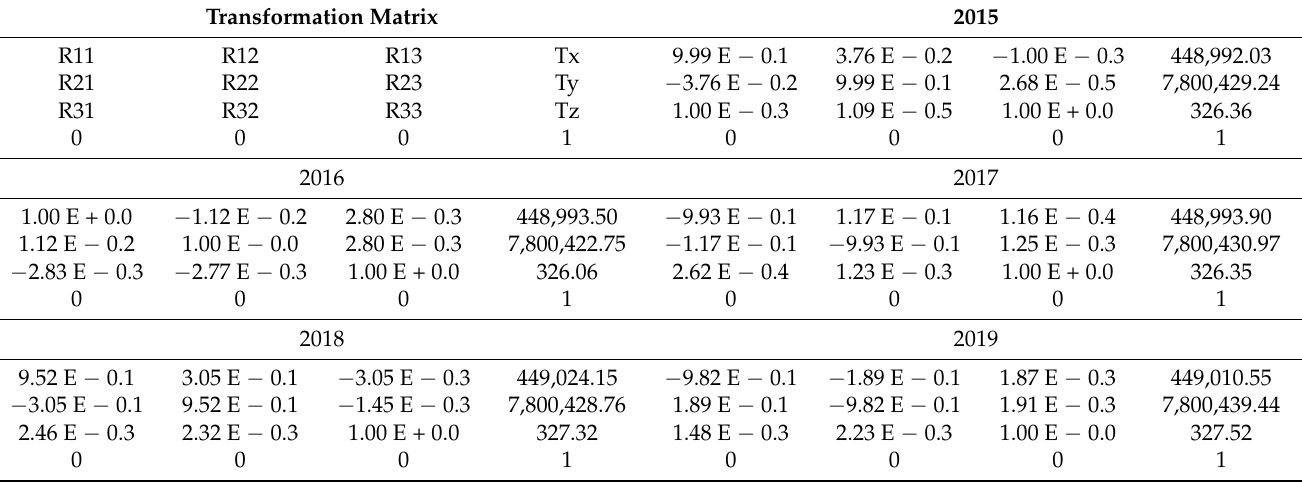
Table A2. Transformation matrices applied to each HLS scan point cloud as part of Step 2. For the transformation matrix, R is a standard 3 × 3 rotation matrix and T is a translation vector. Let P be a 3D point, the transformed point P’ will be such that: P’ = R.P + T. E =